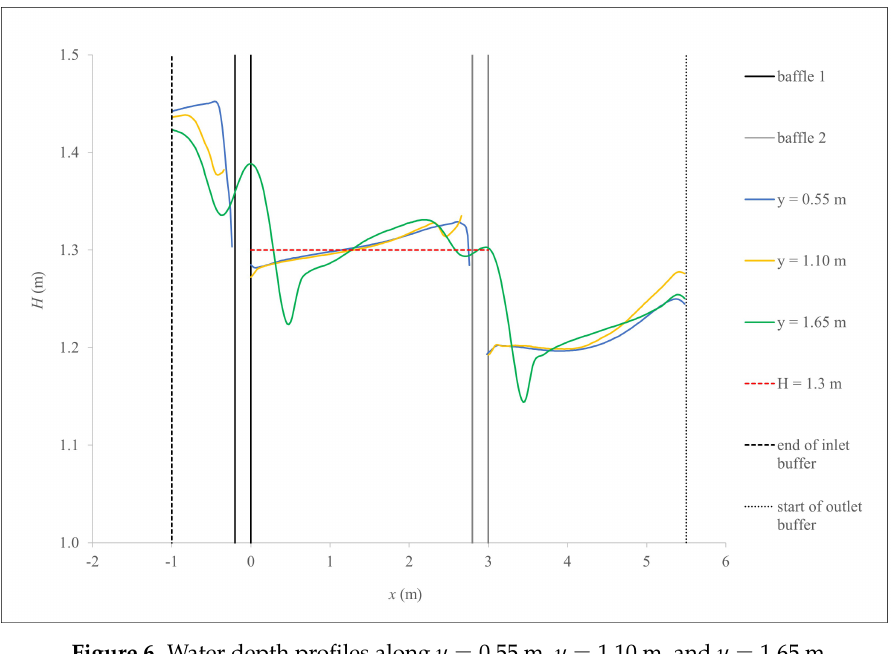
Figure 6. Water depth profiles along y = 0.55 m, y = 1.10 m, and y = 1.65 m.